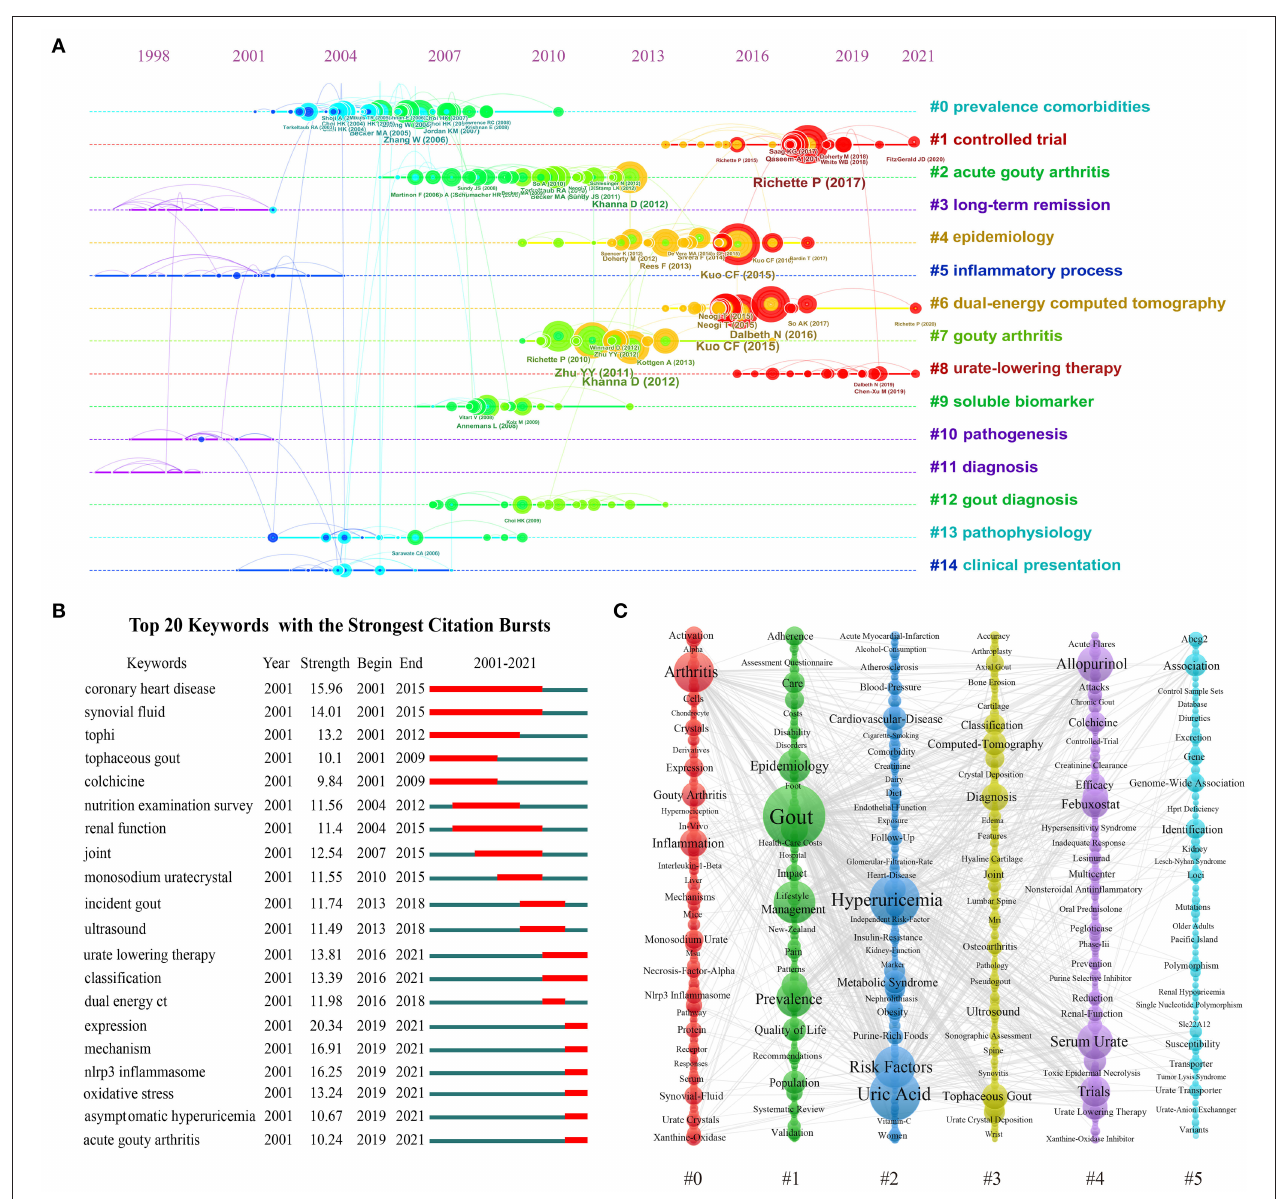
FIGURE 5 | (A) The timeline graph of co-cited reference clusters. (B) The top 20 keywords with the strongest citation bursts. (C) The co-occurrence view of the keywords, in which each column represents a cluster of studies generated by